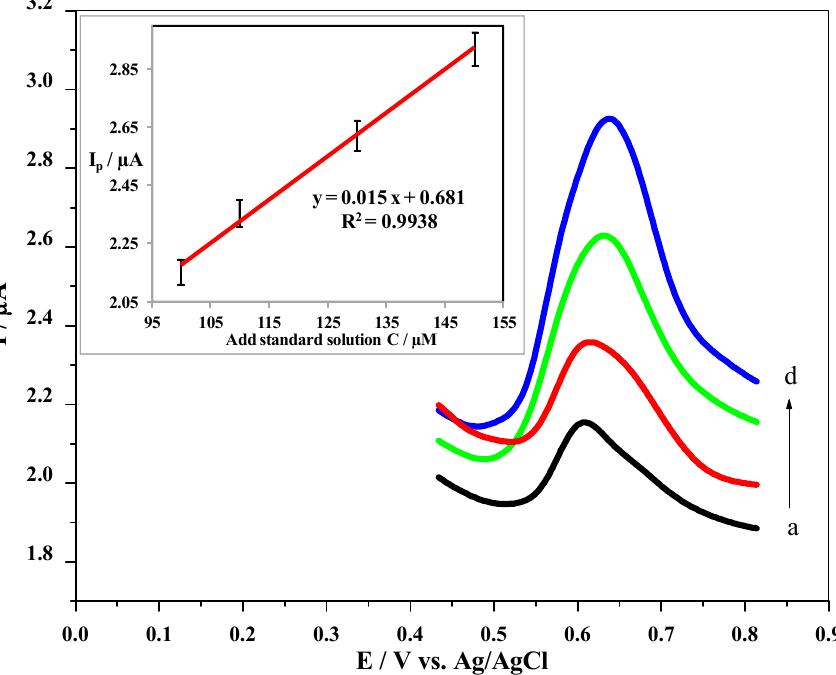
Figure 15. DPVs were recorded at the GO/Nq/GCE upon the addition of known concentrations of NIC (a to d: 100, 110, 130, and 150 µM) in 0.1 M of Na 2 SO 4 (pH 8.0) with a scan rate of 100 mV/s. Inset shows the corresponding calibration curve. Table 2. Detection of NIC in practical samples at the GO/Nq/GCE.